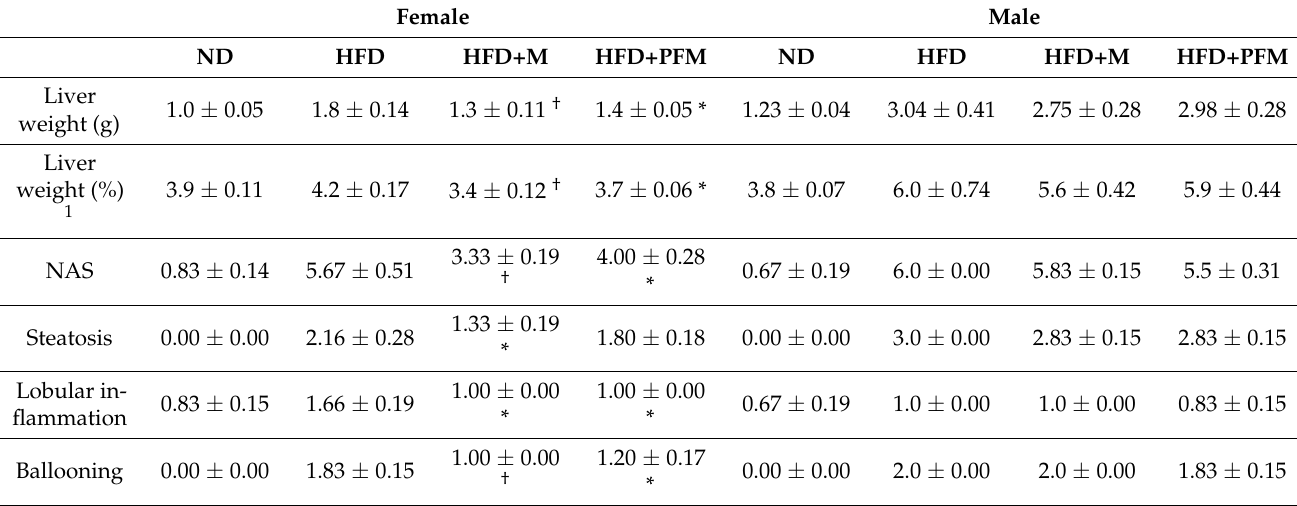
Table 3. Liver weight and nonalcoholic fatty liver disease (NAFLD) activity score (NAS). Female